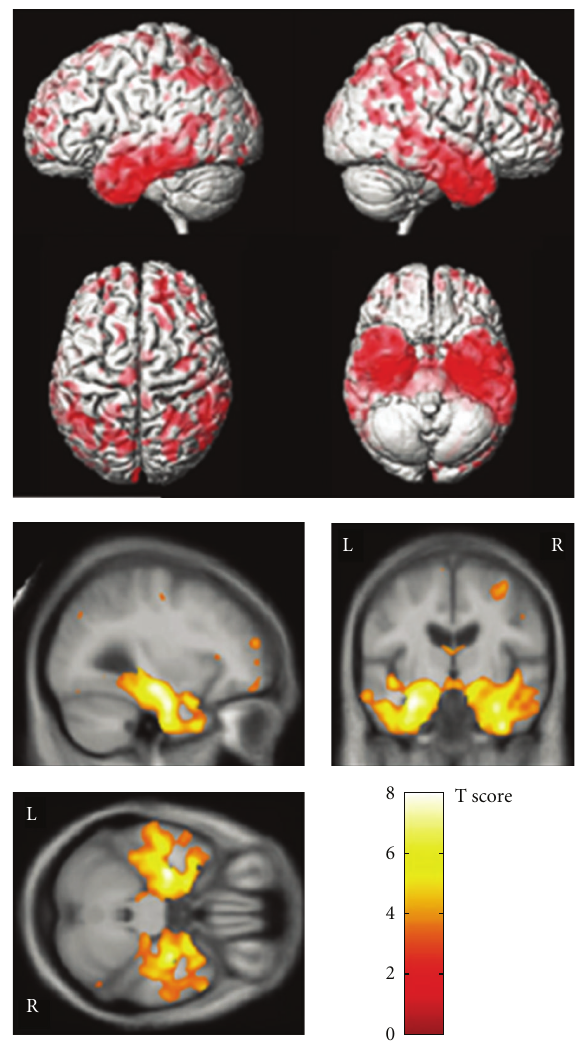
Figure 2: Patterns of grey matter atrophy in patients with AD compared with age-matched control group. The results are shown on a 3D surface render (top) and overlaid on representative axial, coronal and sagittal slices (bottom). L: left; R: right. Adapted and reprinted with permission from Whitwell et al. [18] [Copyright (2005)